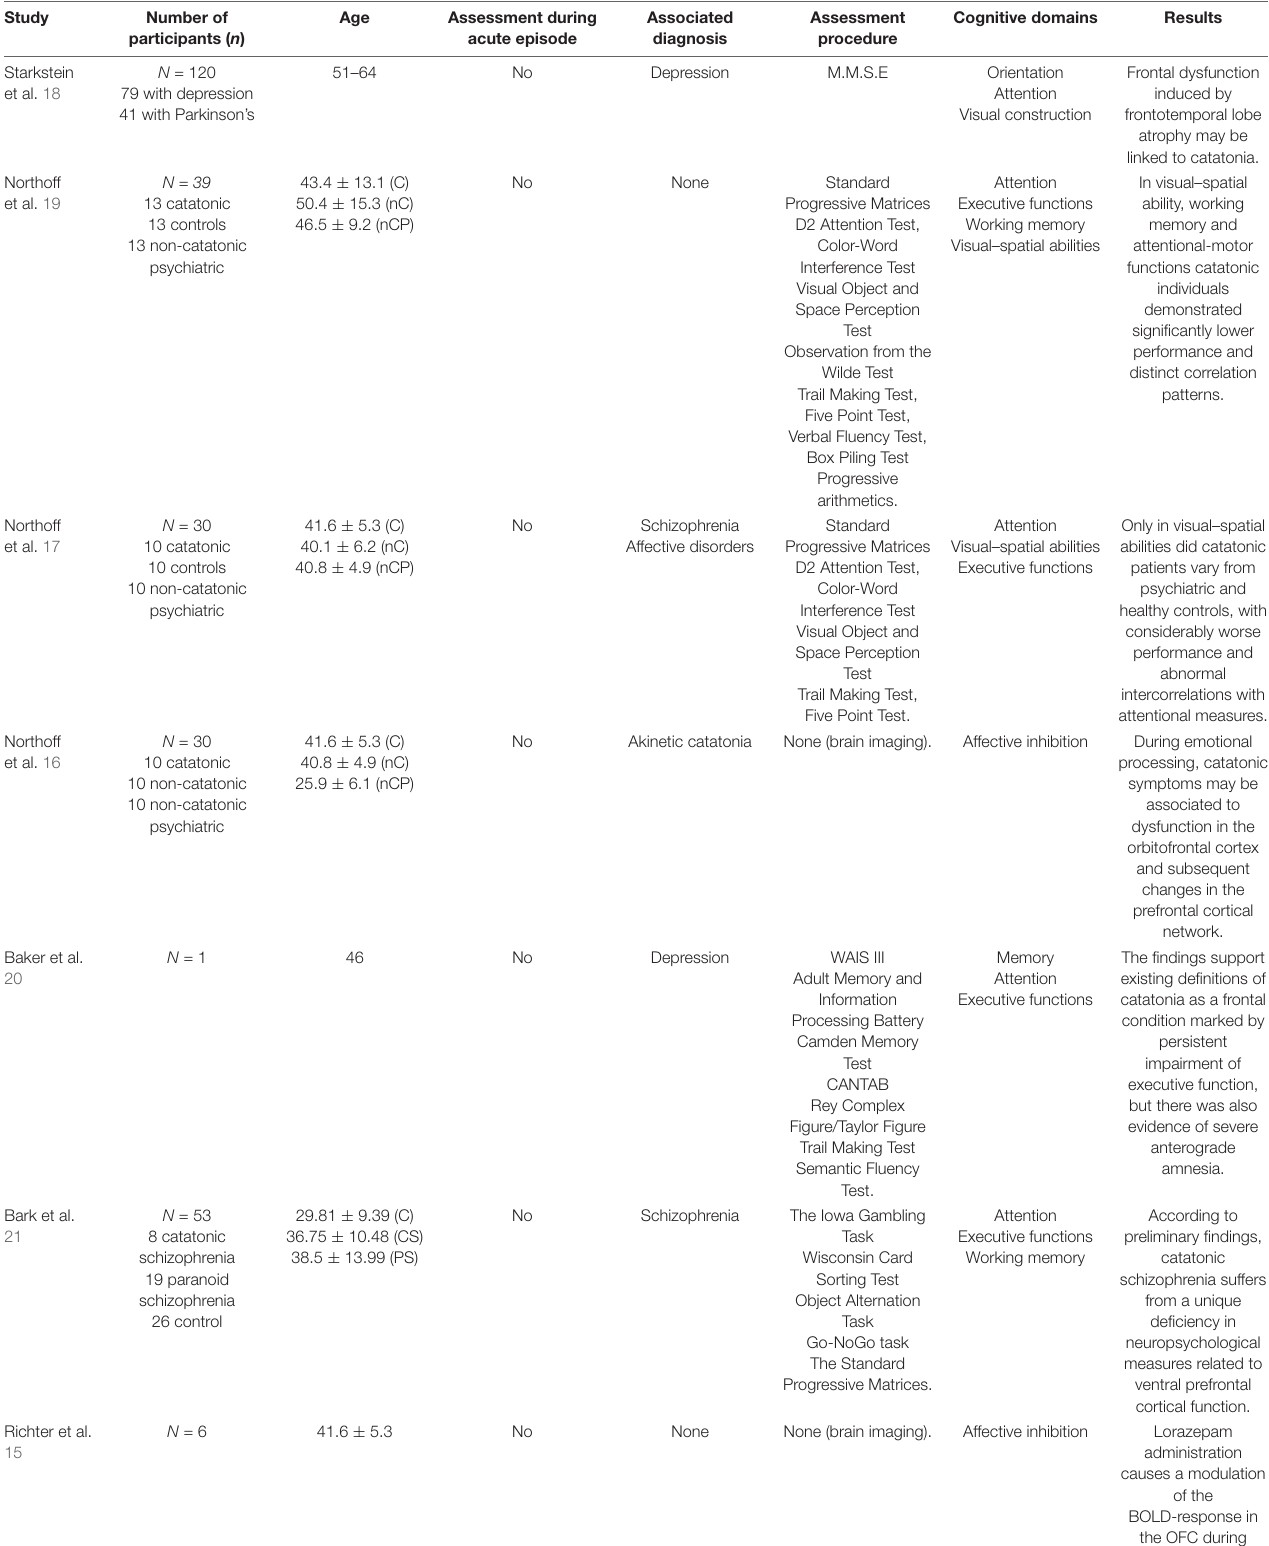
TABLE 3 | Features of the 14 studies reviewed.